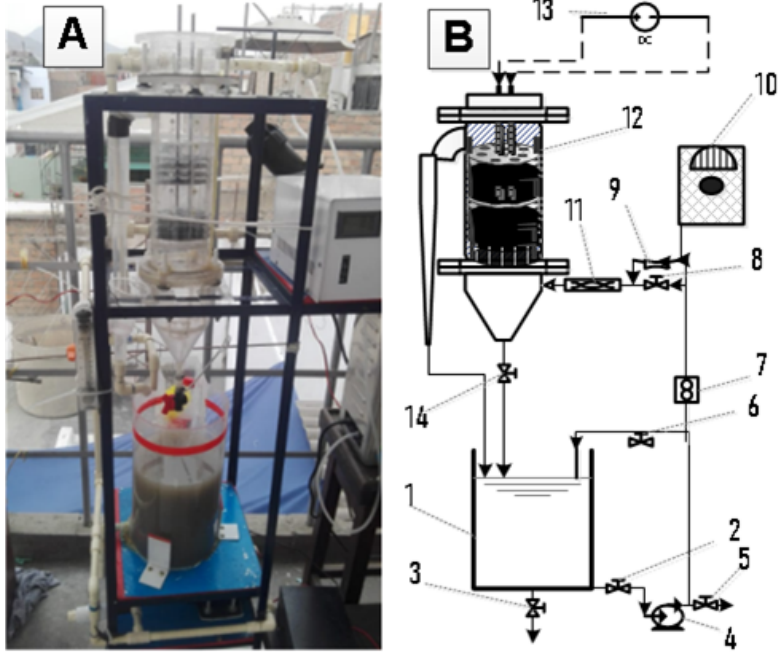
Figure 1. Electrocoagulation and ozone experimental module. ( A ) Photograph of the experimental module doing preliminary tests. The sample is fed to tank 1, followed by the sample being pumped through the flow meter, followed by the Venturi system, dynamic mixer until reaching the electrolytic reactor, once the system is filled again the sample returns to the tank. ( B ) Module diagram, where 1 is the deposit; 2, 3, 5, 6, 8, and 14 stopcocks; 4 recirculation pump; 7 flow meter; 9 Venturi; 10 ozone generator; 11 dynamic mixer; 12 electrocoagulation reactor and 13 current